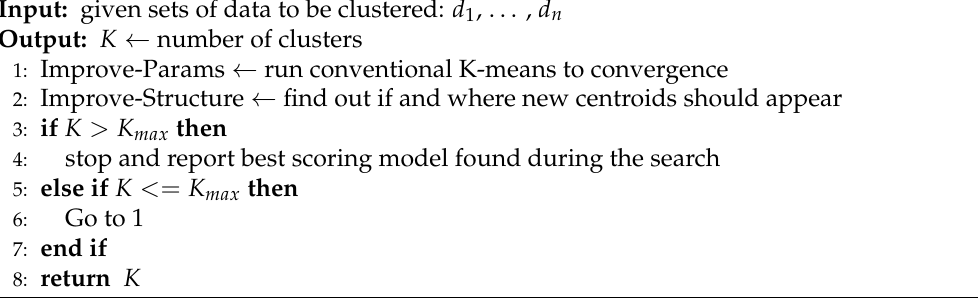
Algorithm 1 Algorithm of X-means Clustering